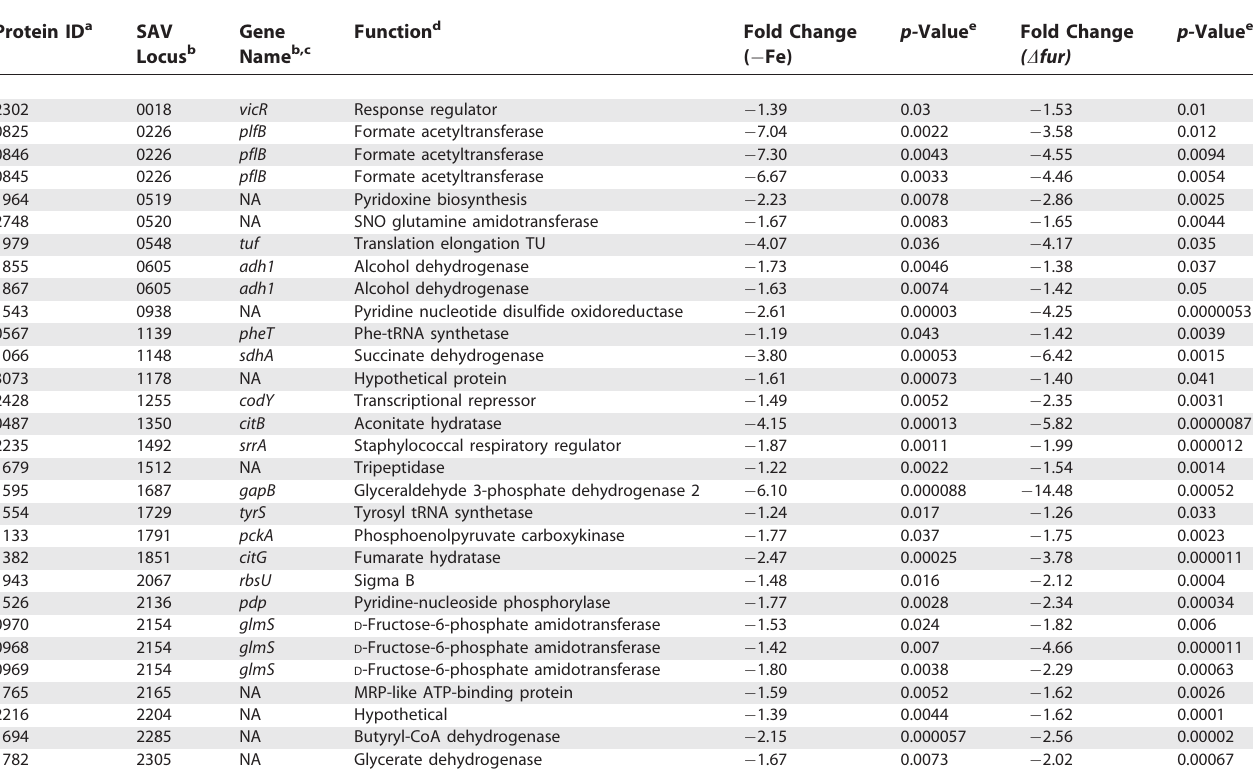
Table 3. Proteins Positively Affected by Fur and Iron Protein ID a SAV Gene Locus b Name